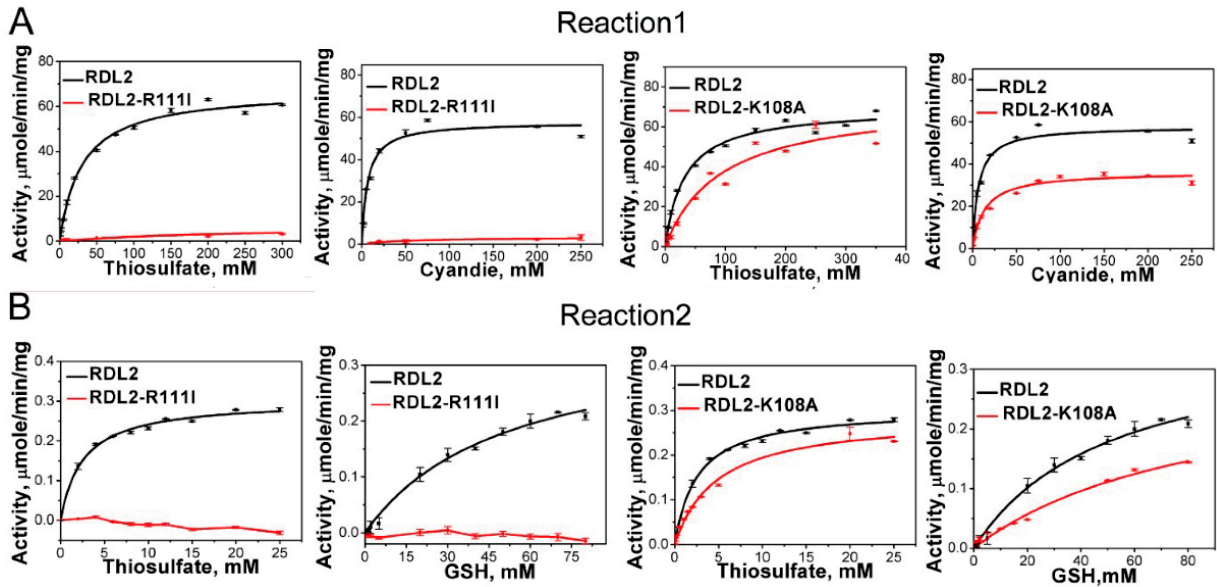
Figure 2. Kinetics of RDL2-catalyzed Reactions 1 ( A ) and 2 ( B ). The data shown as average ± s.d. are all from 3 independent experiments and fitted with Michaelis-Menten equation. Table 2. Kinetic parameters of RDL2-catalyzed Reactions 1 and 2.